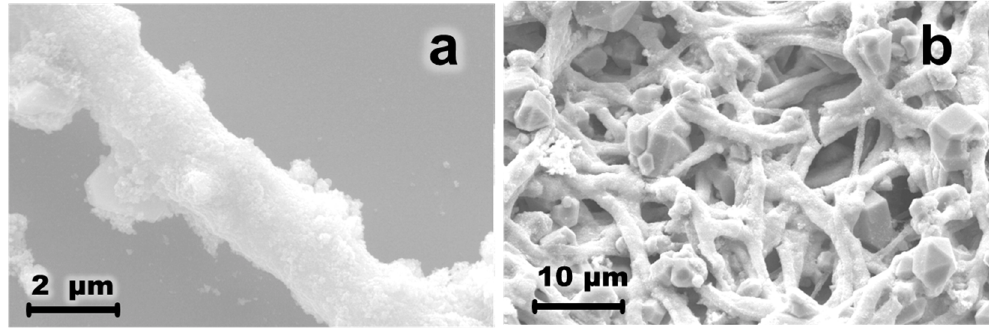
Figure 3. ( a ) SEM image of a single microtubule of Cladosporium sphaerospermum covered with gold and silver nanoparticles FGS. ( b ) SEM image of the substrate obtained with several microtubules of gold and silver nanoparticles used to collect the enhanced Raman spectrum of thiophenol.